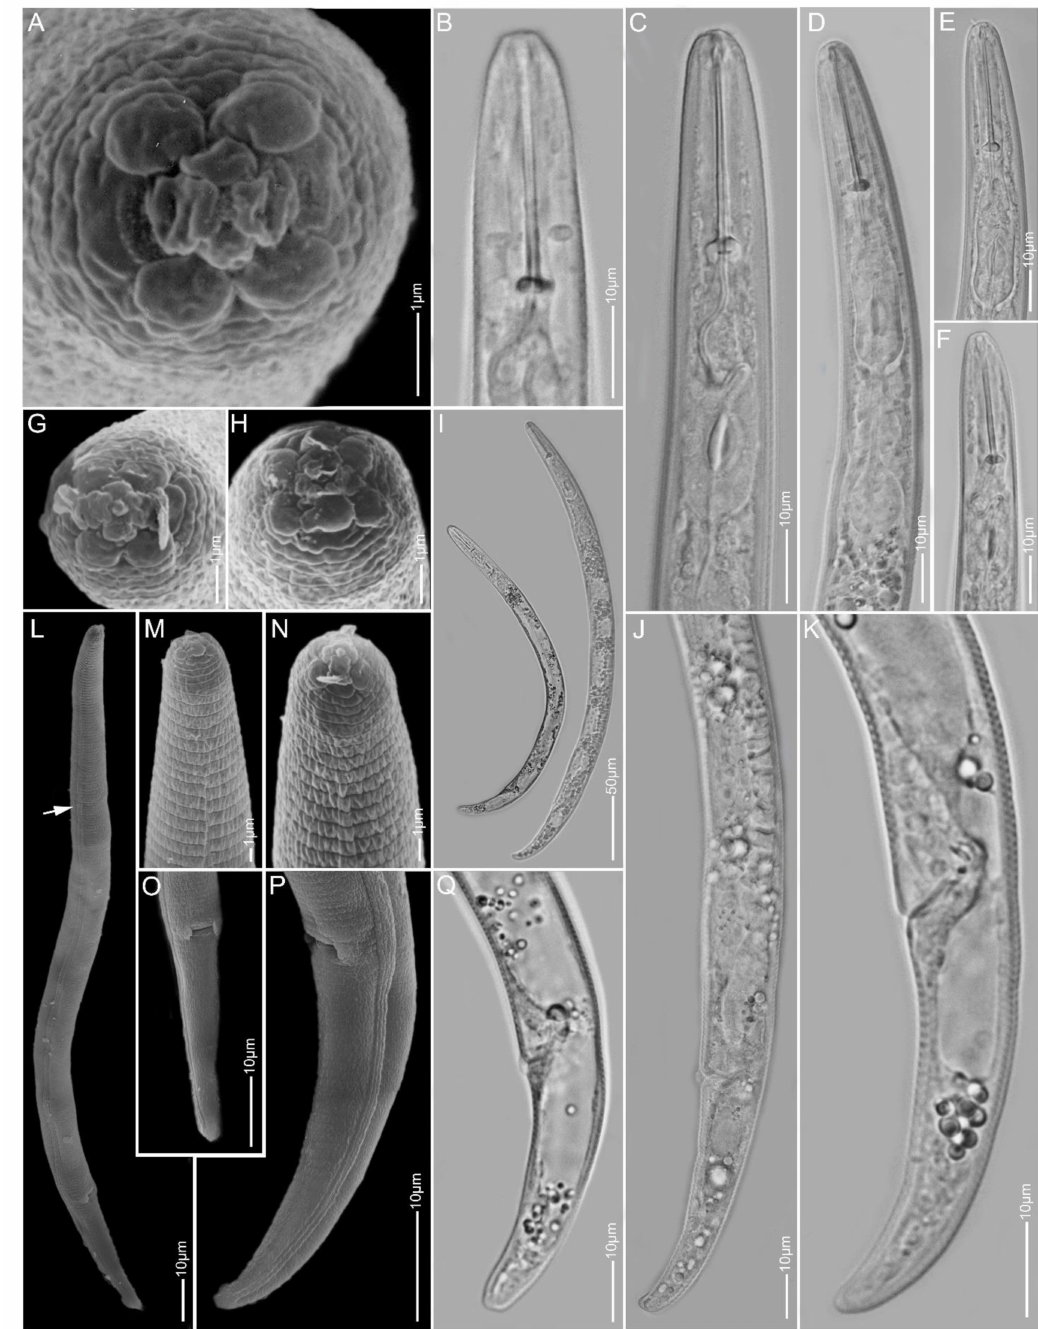
Figure 14. Light and scanning electron microscopy images of Paratylenchus sp.D females; ( A , G , H ) face view; ( B – F , M , N ) anterior region; ( I , L ) total body; ( J , K , O – Q ) tail region; arrow pointed to deirid in